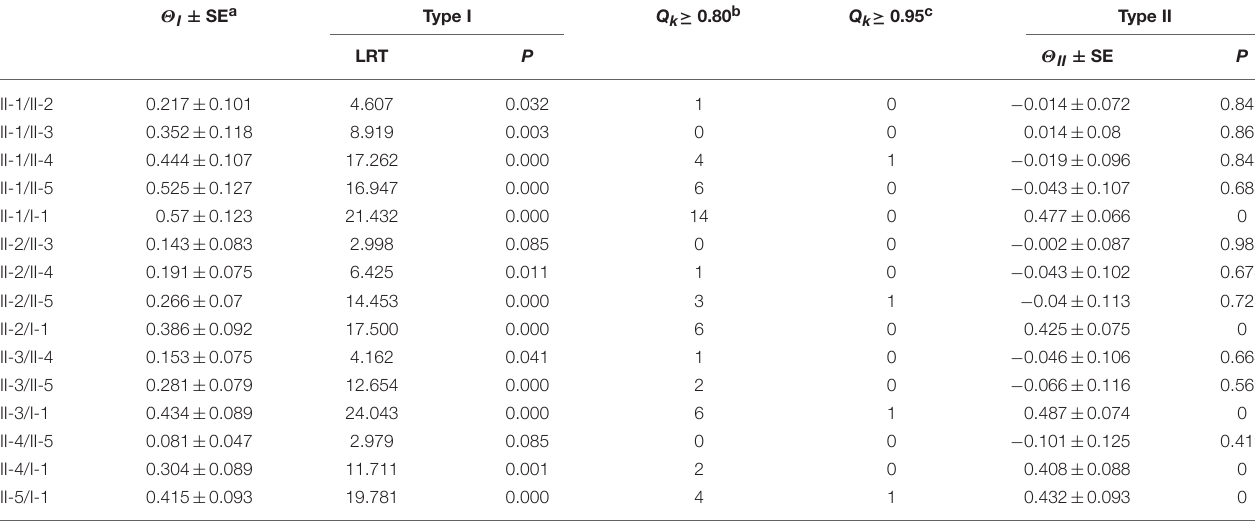
TABLE 2 | Functional divergence between groups of the TPS gene family in